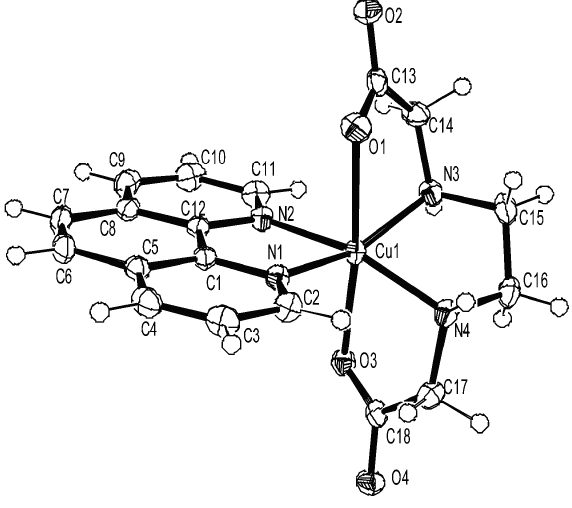
Figure 12. ORTEP view of ternary Copper(II)-phen-edda Complex [Cu(phen)(edda)] [25]. The EPR spectrum of [Cu(phen)(edda)] in frozen aqueous solution at pH 7 shows a pattern characteristic of a tetragonal Cu(II) complex with g || = 2.24 and A || = 17.0 mT. However, the EPR spectra of [Cu(phen)(edda)] in DNA pellet and in A-form DNA fiber at room temperature (Figure 13) are broadened considerably, indicating that the copper(II) coordination sphere is deformed inhomogeneously on the DNA. The observed small Ф dependence of the EPR spectra of the A-form DNA fiber indicates that the complex is oriented randomly on the